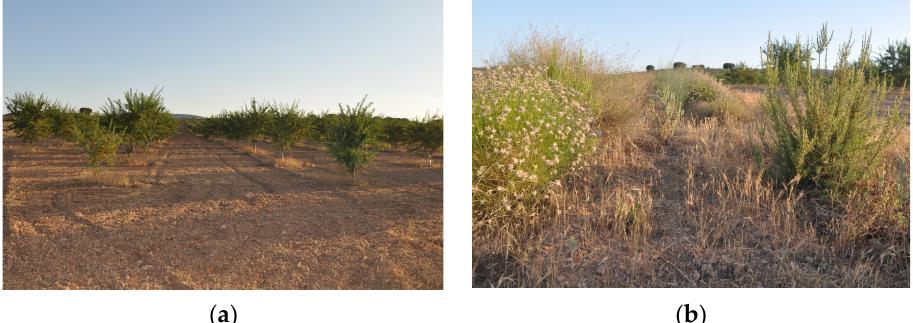
Figure 2. ( a ) Keylines, regenerative almonds; ( b ) aromatics in the study area site, ERC Camp Altiplano—author’s photo 07/2022 (MM/YYYY).